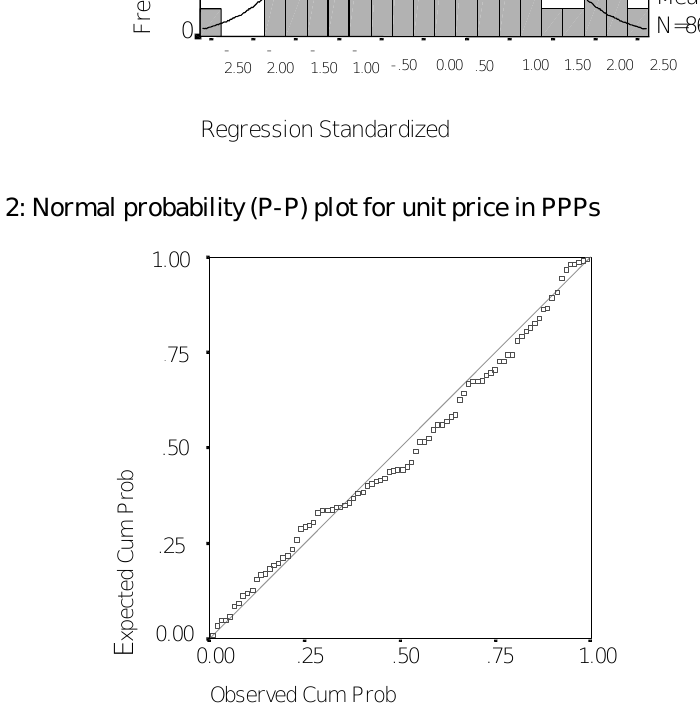
Figure 3: Studentized residuals versus predicted values for unit price in